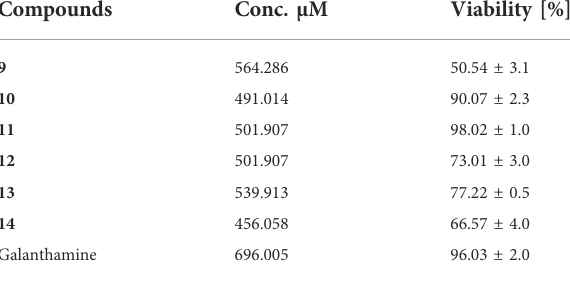
TABLE 4 Viability of human neutrophils (1 × 10 7 cells/ml) in the presence of compounds 9 – 14.